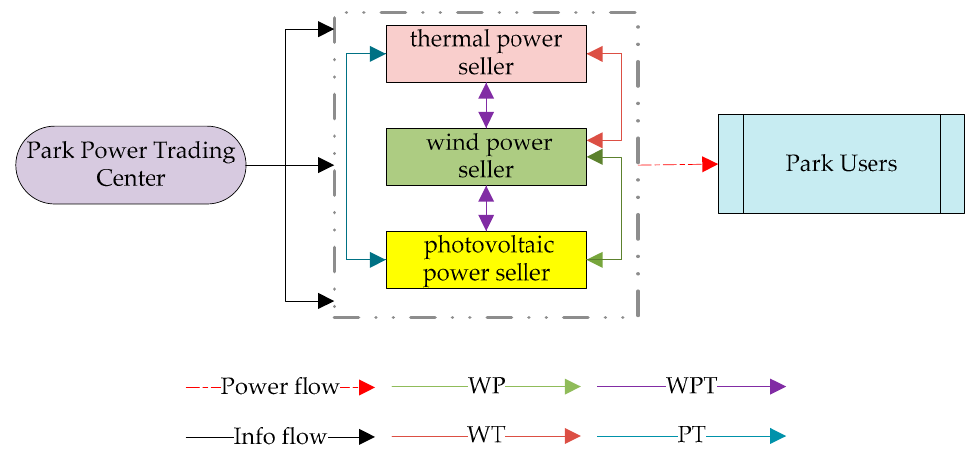
Figure 1. Power Supply System of the Industrial Park.